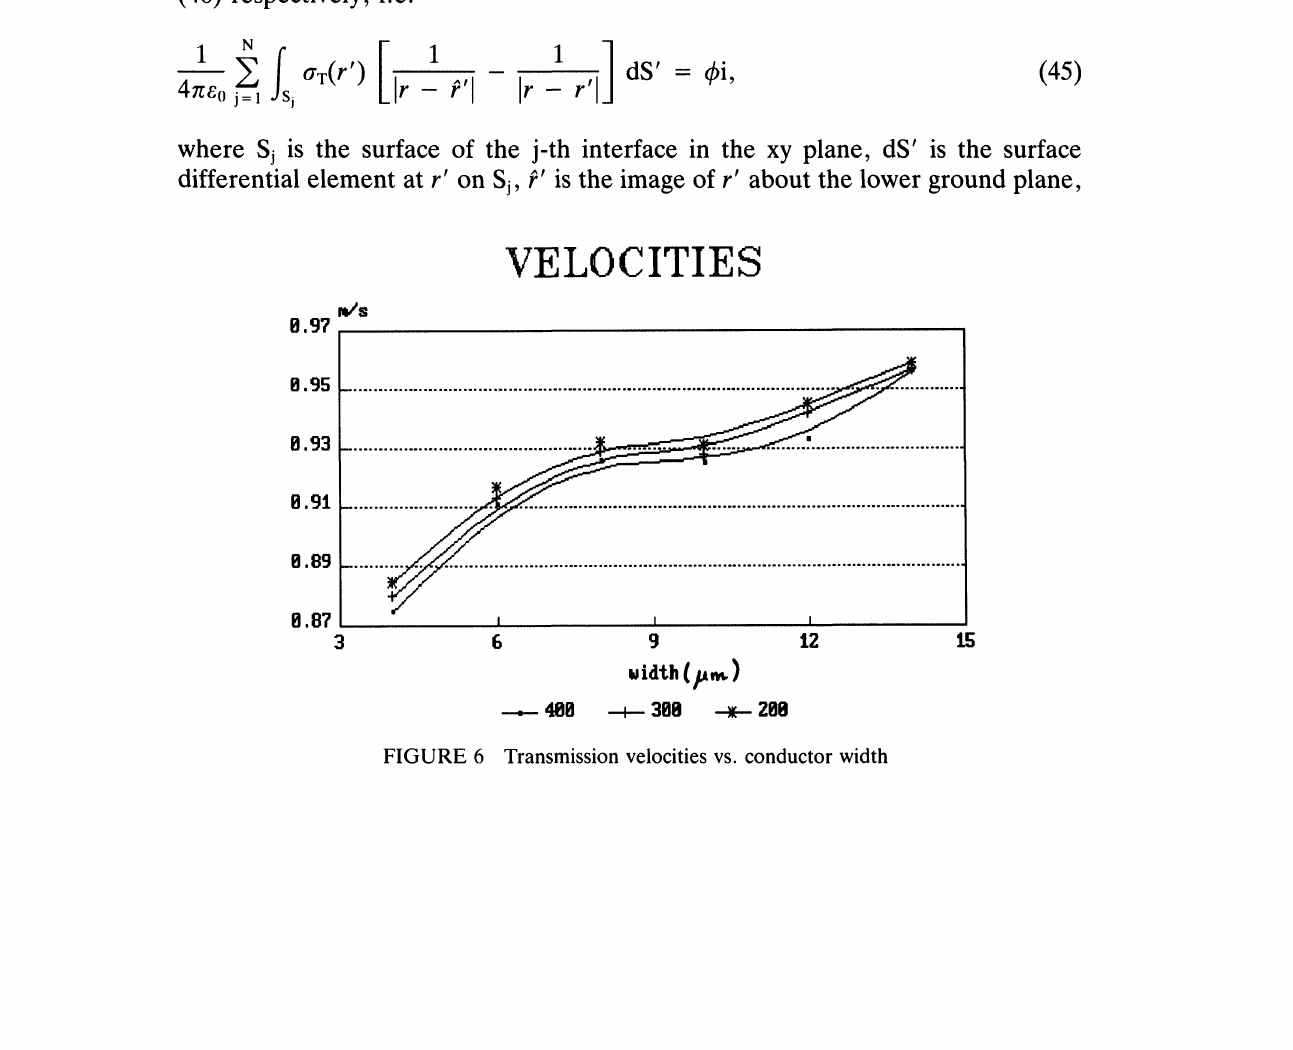
FIGURE 5 Characteristic impedance vs. width of the conductor